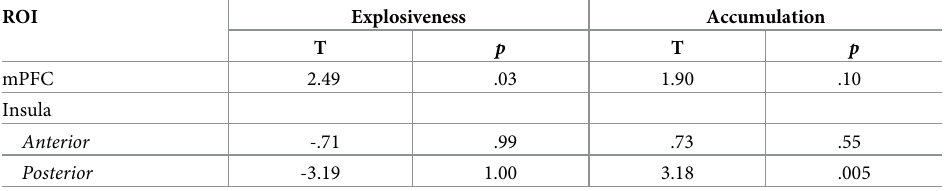
Table 2. Region of interest analyses predicting neural activity in the specific regions observed by Resibois, Ver- duyn & colleagues [11] to underlie emotion explosiveness (resp. accumulation).